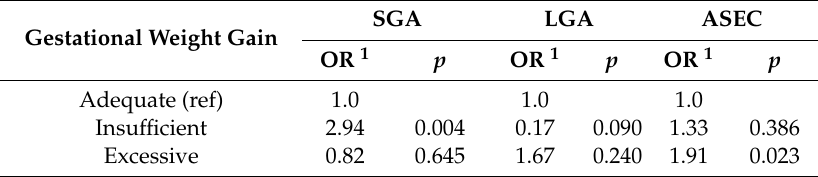
Table 3. Associations between pregnancy outcomes and gestational weight gain, classified according to compliance with the gestational weight gain recommendations from the Institute of Medicine [1], among women in the GraviD cohort.